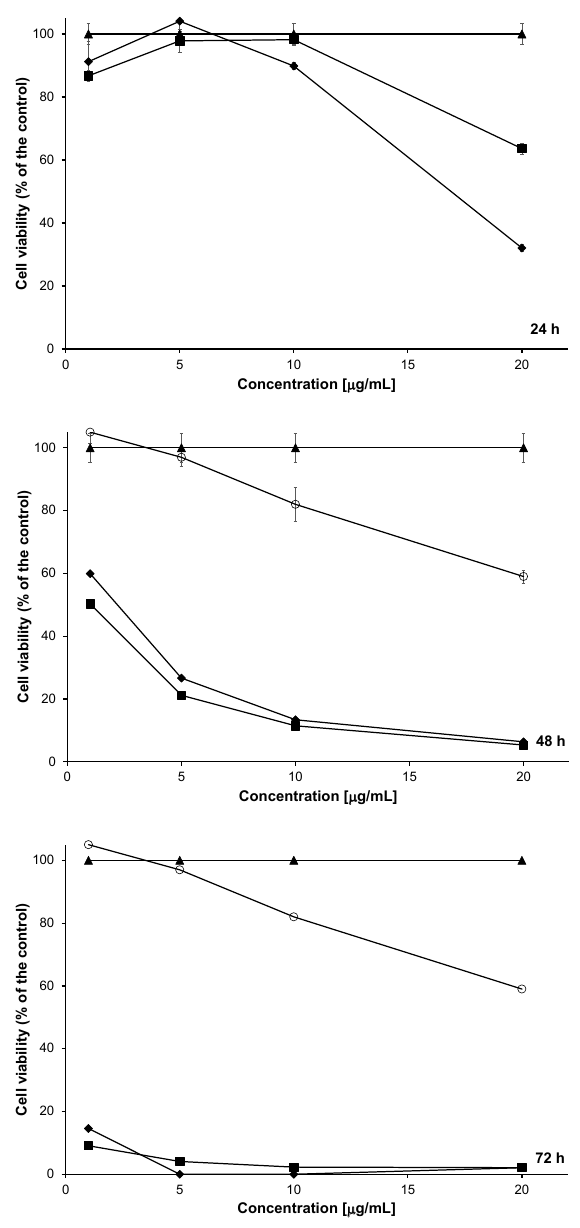
) on viability ), MTT ♦ ▲